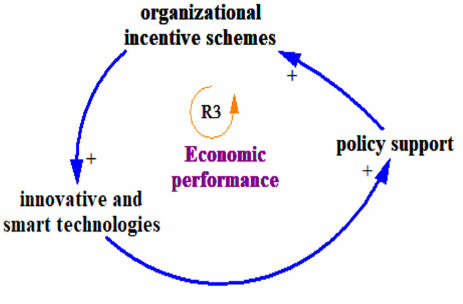
Figure 8. Reinforcing loop